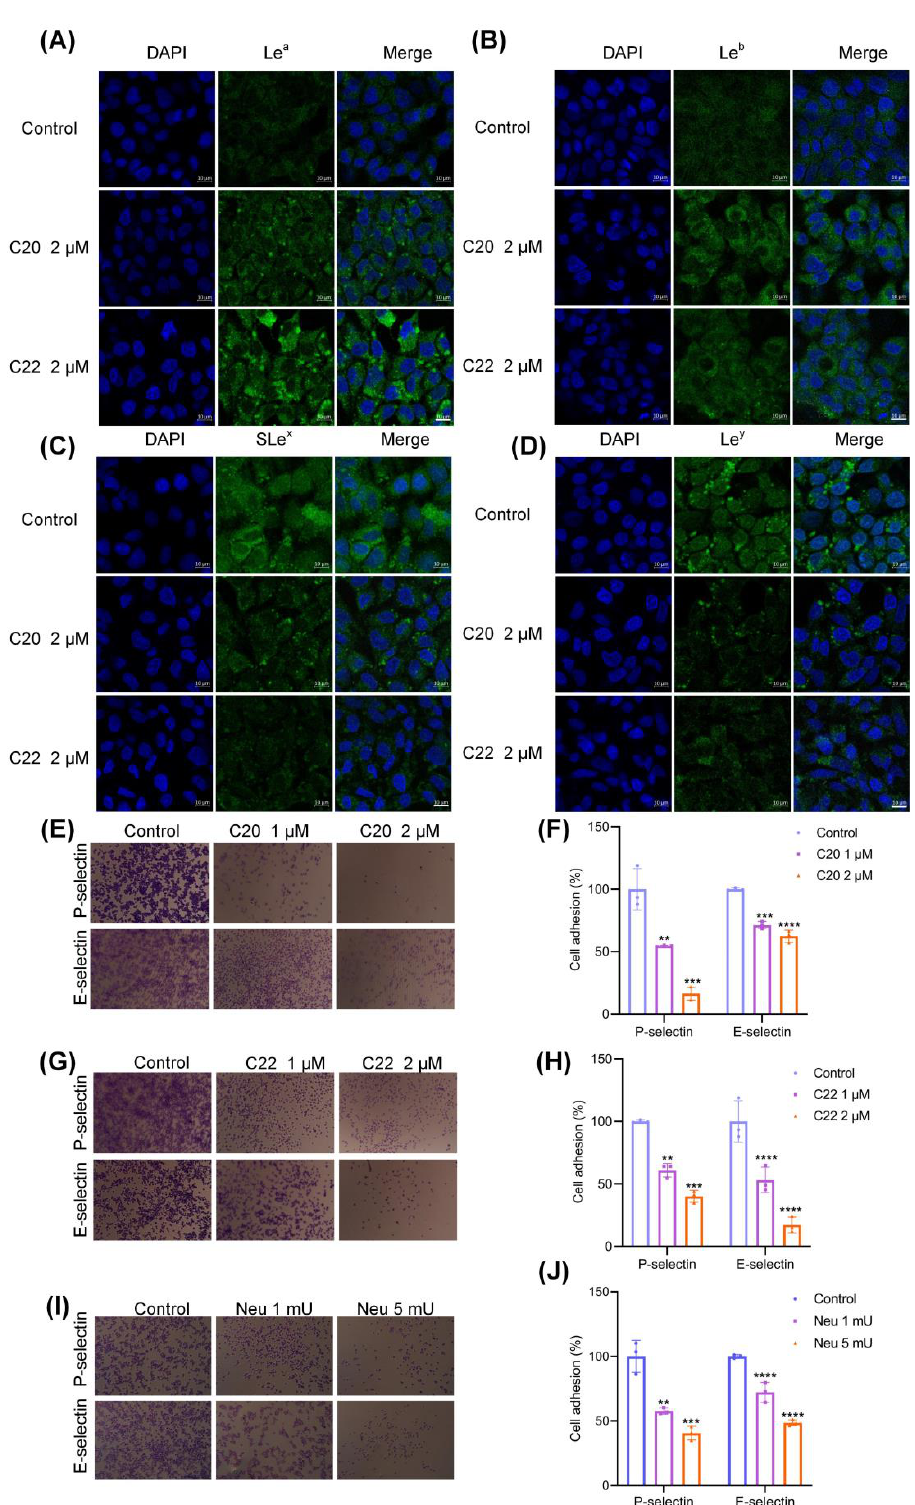
Figure 4. C20 and C22 modified cell surface glycosylation and inhibited the interactions between HepG2 and E/P-selectin. HepG2 cells were treated with 2 μM C20/C22 for 24 h, and the expression of Lewis oligosaccharides on the surface of HepG2 cells was detected by immunofluorescence